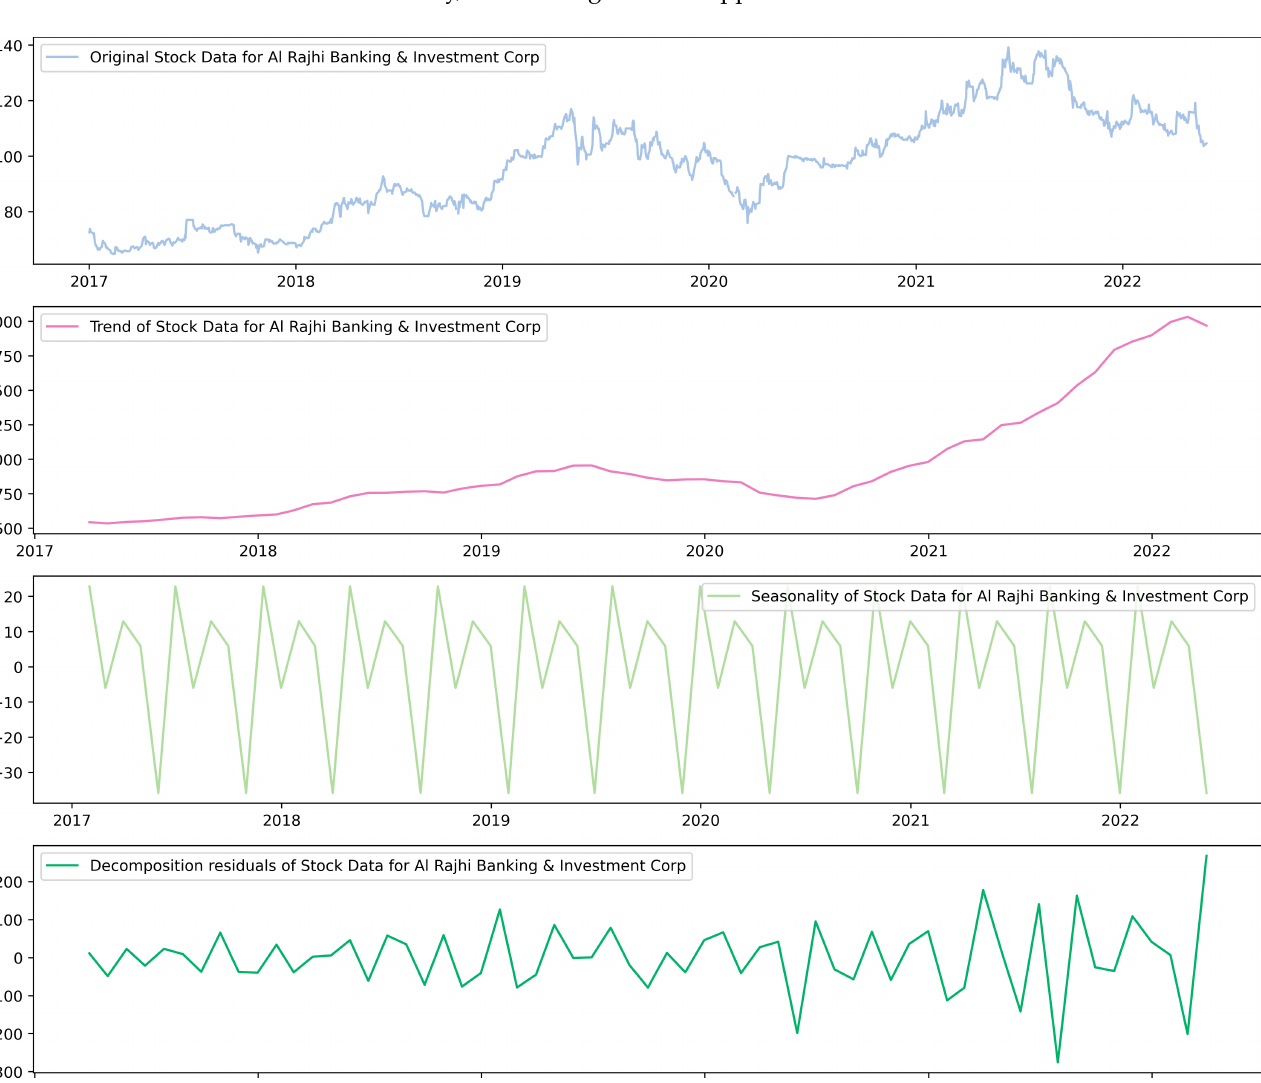
Figure 11. Decomposition of 1120 Stock Data: Trend, Seasonal (Periodic), and Residual